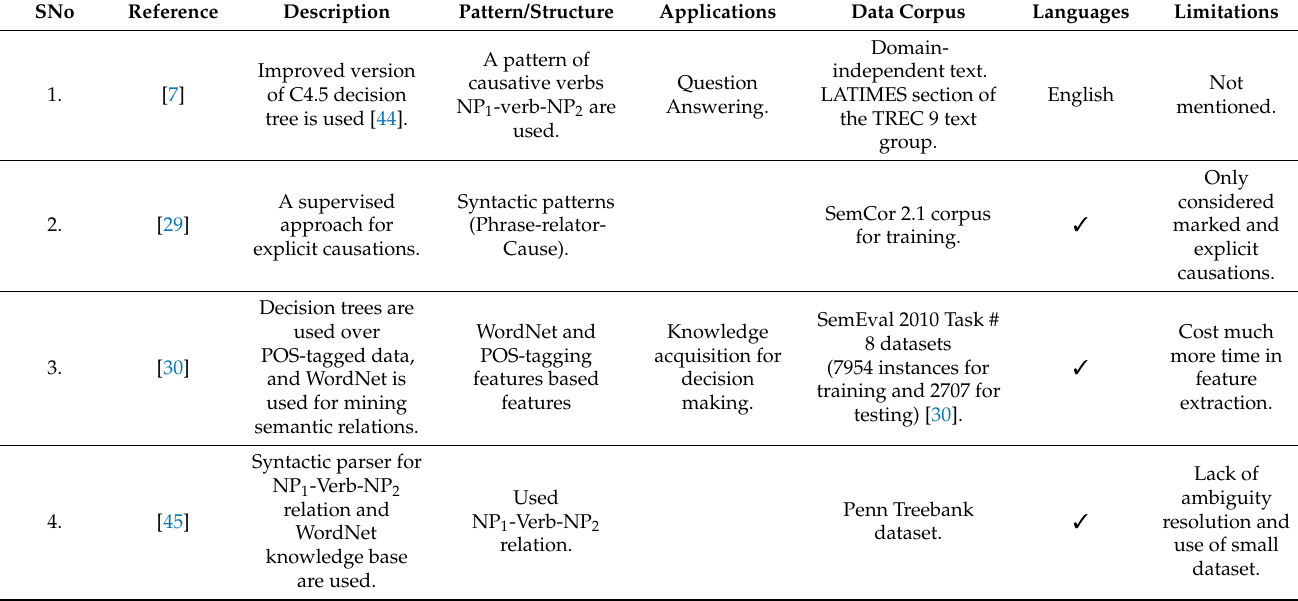
Table 1. Summary of linguistics and Cue phrase-based ML